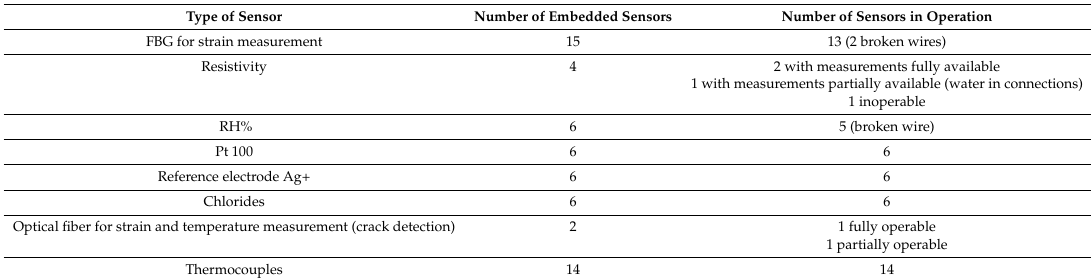
Table 3. Sensors in